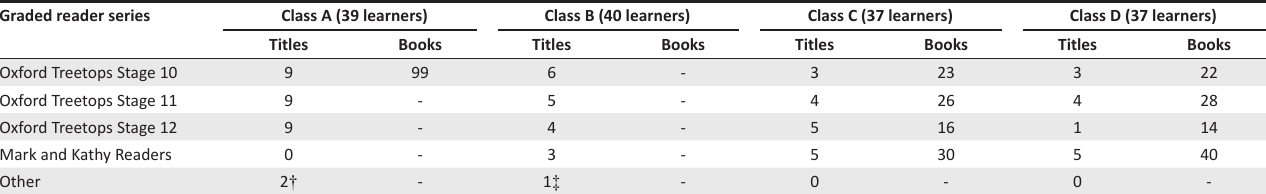
TABLE 6: Availability of graded readers (titles and books) per classroom. Graded reader